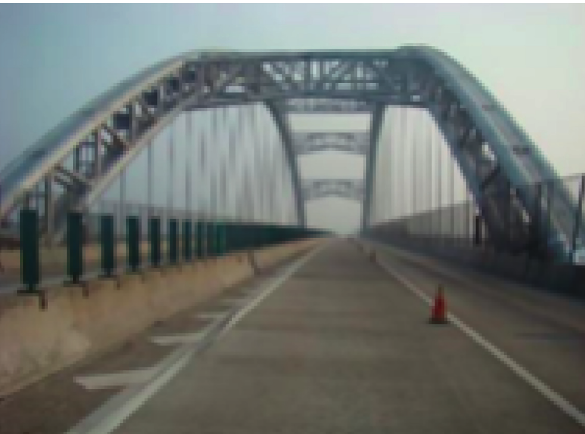
Figure 6: Liujing Yujiang superbridge.